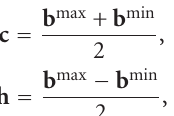
a negative results (or a zero) are obtained, the vertices are located on both sides of (or on) the plane, and therefore, an intersection is detected. There are other smarter methods where only two points have to be inserted into the plane equation; for an OBB, there are two diagonally opposite corners on the box that are the maximum distance apart, when measured along the plane’s normal. Every box has four diagonals formed by its corners. Taking the dot product of each diagonal’s direction with the plane’s normal, the largest